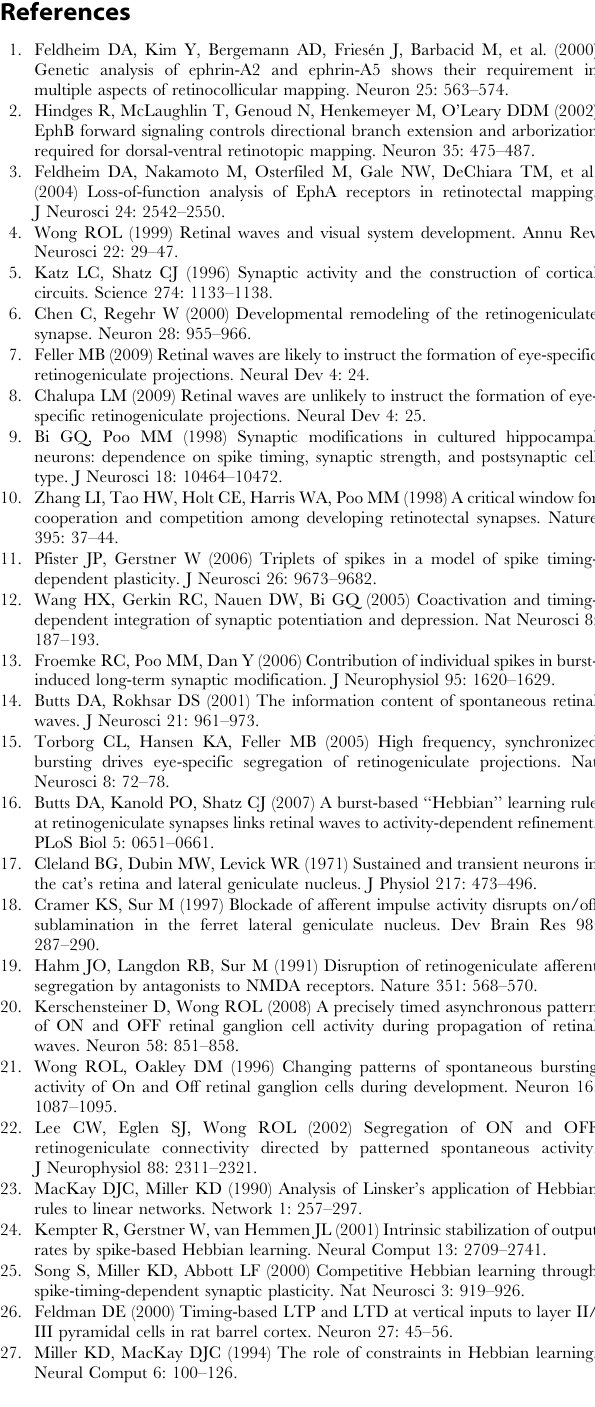
Table S1 Segregation results for ferret using STDP and BTDP. Table S2 Correlation fits for